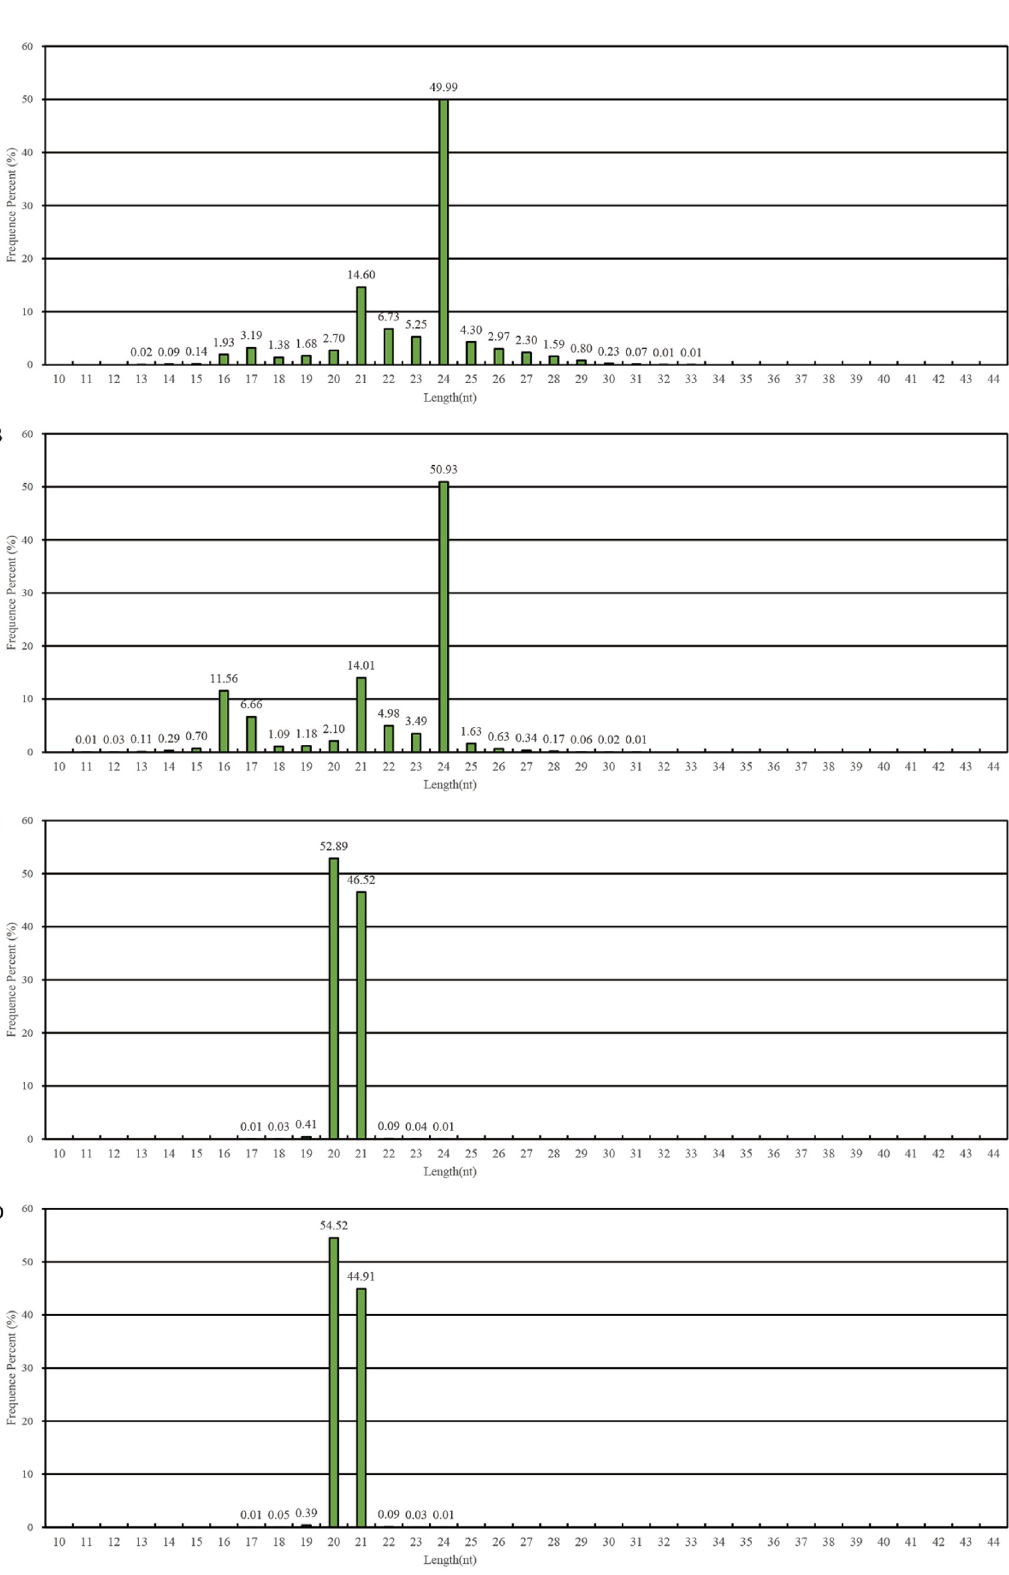
Fig 2. Distribution of fragment lengths in wild and mutant wheat strain by small RNA sequencing and degradome sequencing. A) wild strain by small RNA sequencing; B) mutant by strain small RNA sequencing; C) wild strain by degradome sequencing; D mutant strain by degradome sequencing. doi:10.1371/journal.pone.0137773.g002 PLOS ONE | DOI:10.1371/journal.pone.0137773 September 15,